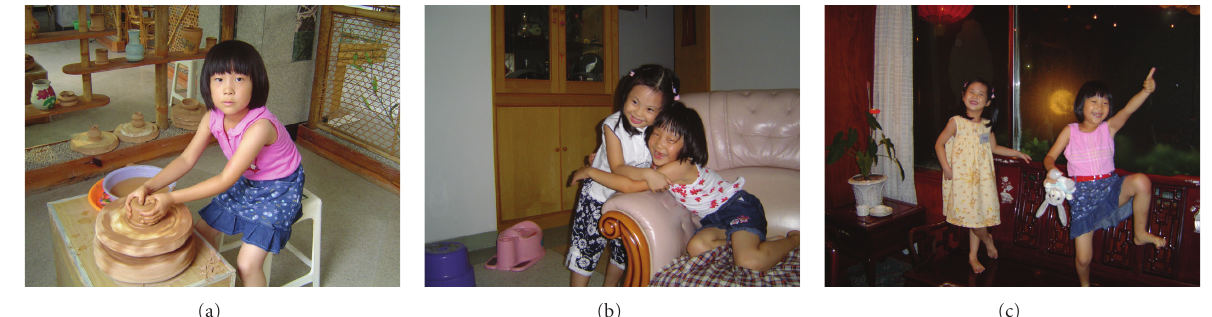
Figure 3: Some learned pattern images.